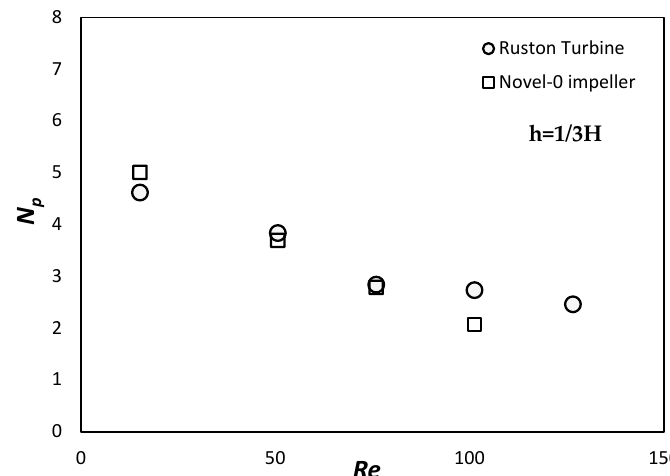
Figure 10. The power number N p obtained from experimental measurement as a function of the Reynolds number and for h = 1 / 3 H .